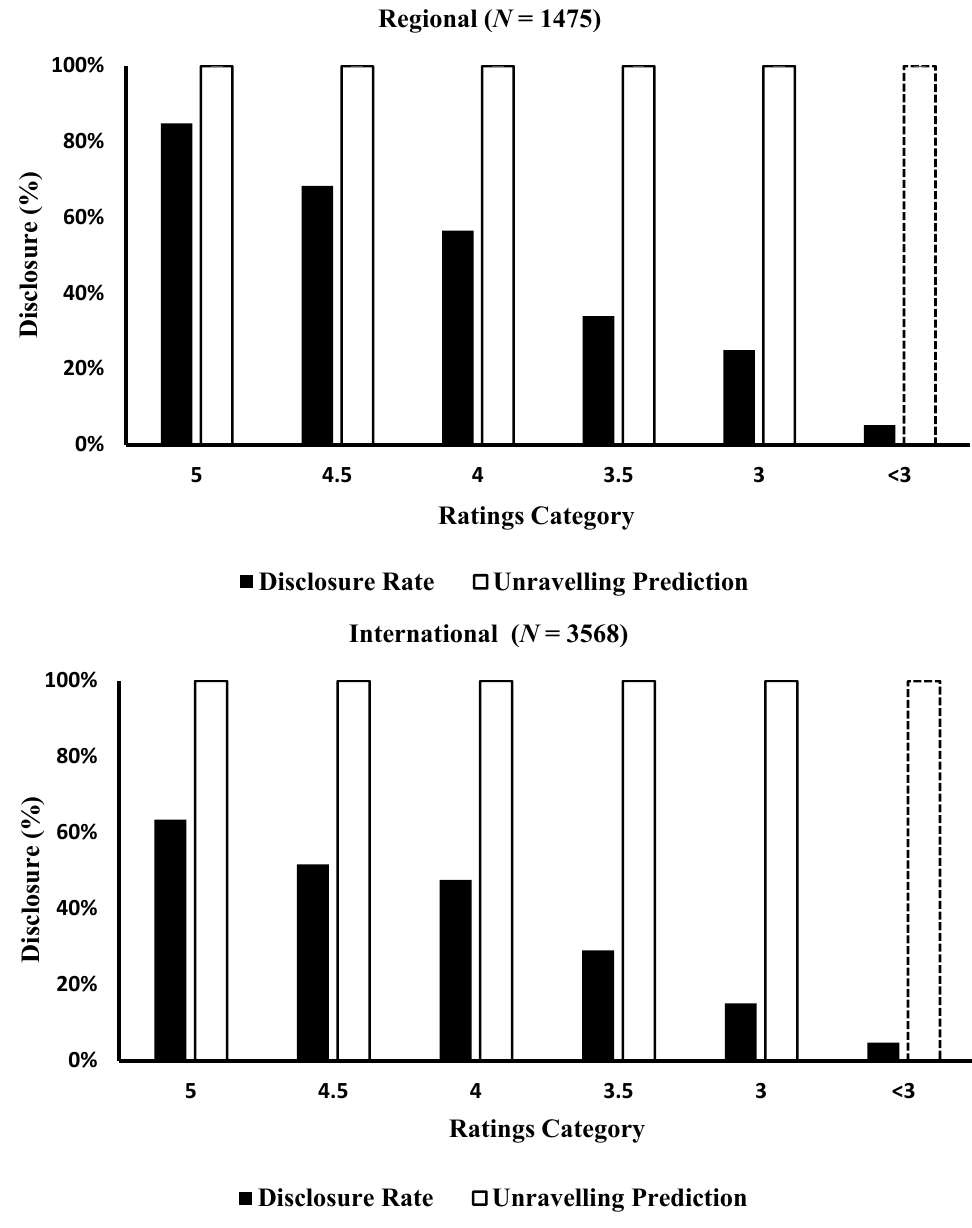
Figure 1. Observed and predicted rating disclosures by TripAdvisor category. Table 4. Disclosure Rate by TripAdvisor Category–Regional &